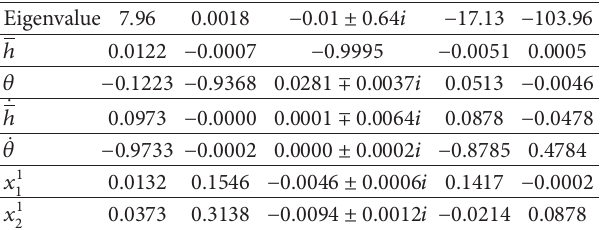
Table 3: Eigenvectors of aeroelastic models with 𝑈 = 24